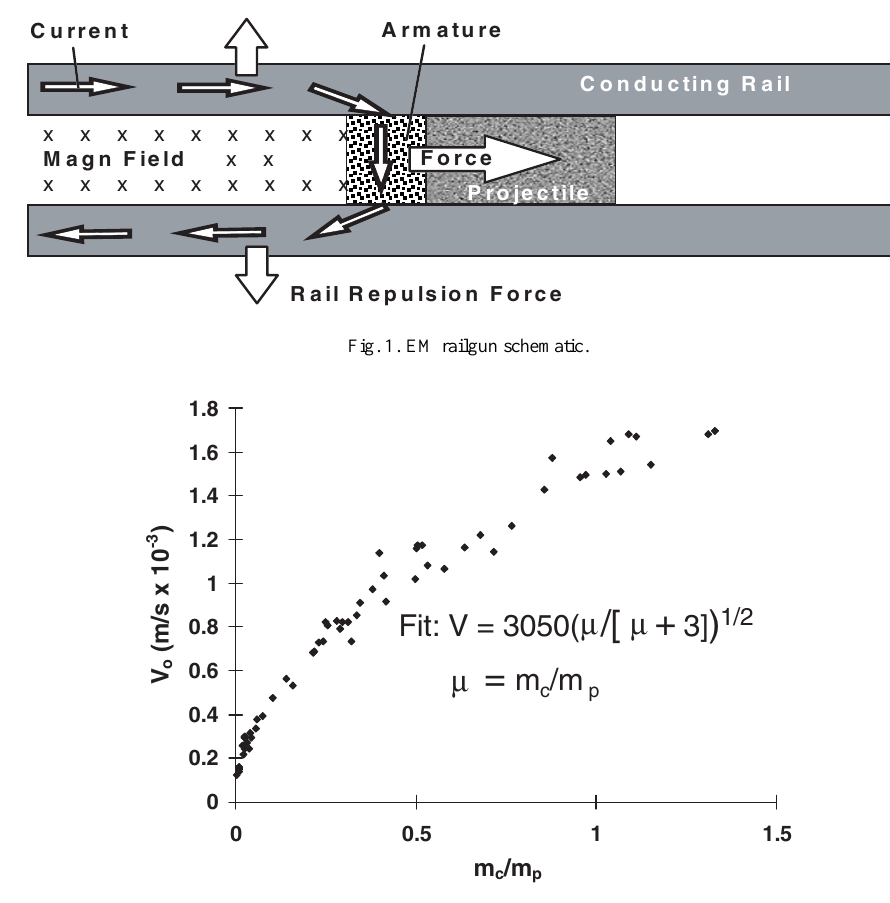
Fig. 2. Velocity vs charge to mass ratio for a wide range of powder